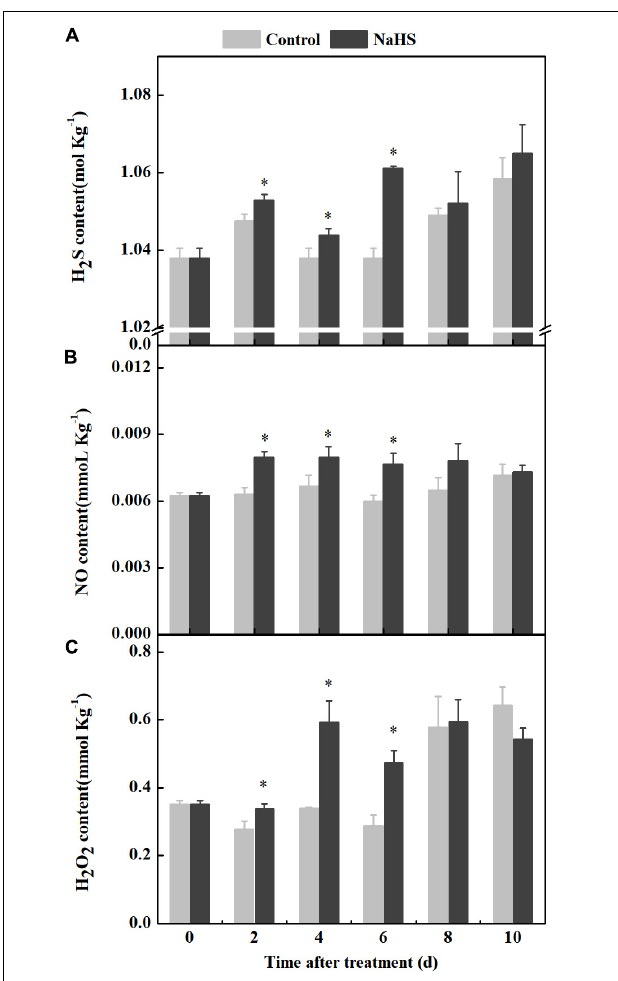
FIGURE 2 | Changes in endogenous H 2 S, NO, and H 2 O 2 contents in apples after NaHS treatment. H 2 S (A) , NO (B) , and H 2 O 2 (C) . The light gray and black bars represent the control and NaHS treatments, respectively. The bars represent the standard error of the mean ( ± SE). ∗ Significant differences at P < 0.05.